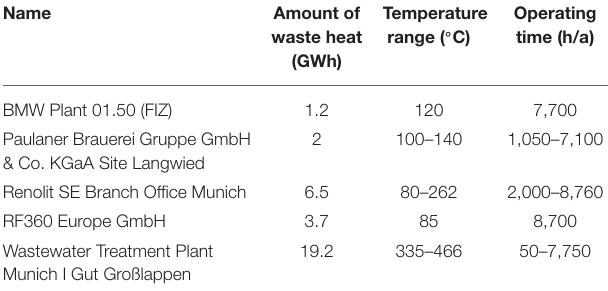
TABLE 1 | Waste heat sites Munich (Source: Bavarian State Office for the Environment,